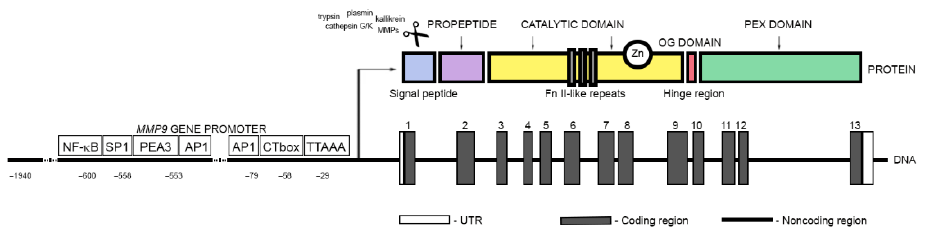
Figure 1. A schematic representation of the MMP9 gene and protein organization. The exons are indicated by the numbered grey rectangles. The 5 ′ -untranslated and 3 ′ -untranslated regions (UTR) are indicated by white boxes. The 5 ′ -flanking region includes relative positions of key transcription factor binding sites. The domain structure of the MMP9 protein starts from a signal peptide (lilac square), followed by a propeptide (blue rectangle). An O-glycosylated (OG) domain (red rectangle) is located between a catalytic domain and a hemopexin (PEX) domain (green rectangle); it comprises a zinc-binding active-site motif (Zn) and tree fibronectin-like (Fn II-like) repeats. Removal of the prodomain is necessary for MMP9 activation and can be mediated by several proteases, such as trypsin, plasmin, cathepsin G or K, kallikrein, and other metal-